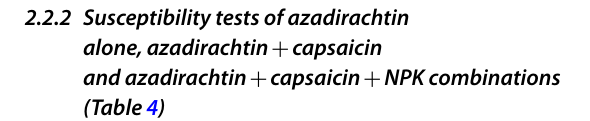
Table 3 Comparative toxicity of capsaicin compound and NPK fertilizer against susceptible strain IRD Aedes albopictus tested at the larval stage